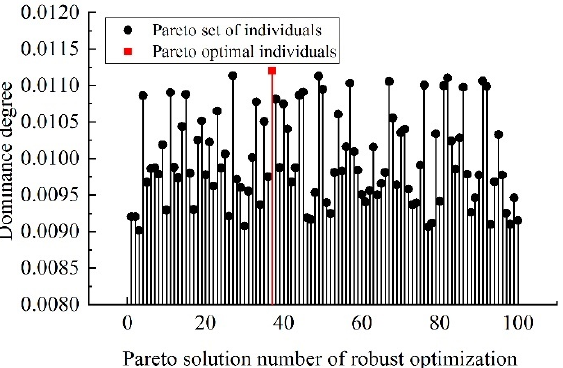
Figure 20. Dominance degree distribution of the Pareto optimal solution set. Table 8 provides the optimal design variables for the wheelset lifting mechanism.